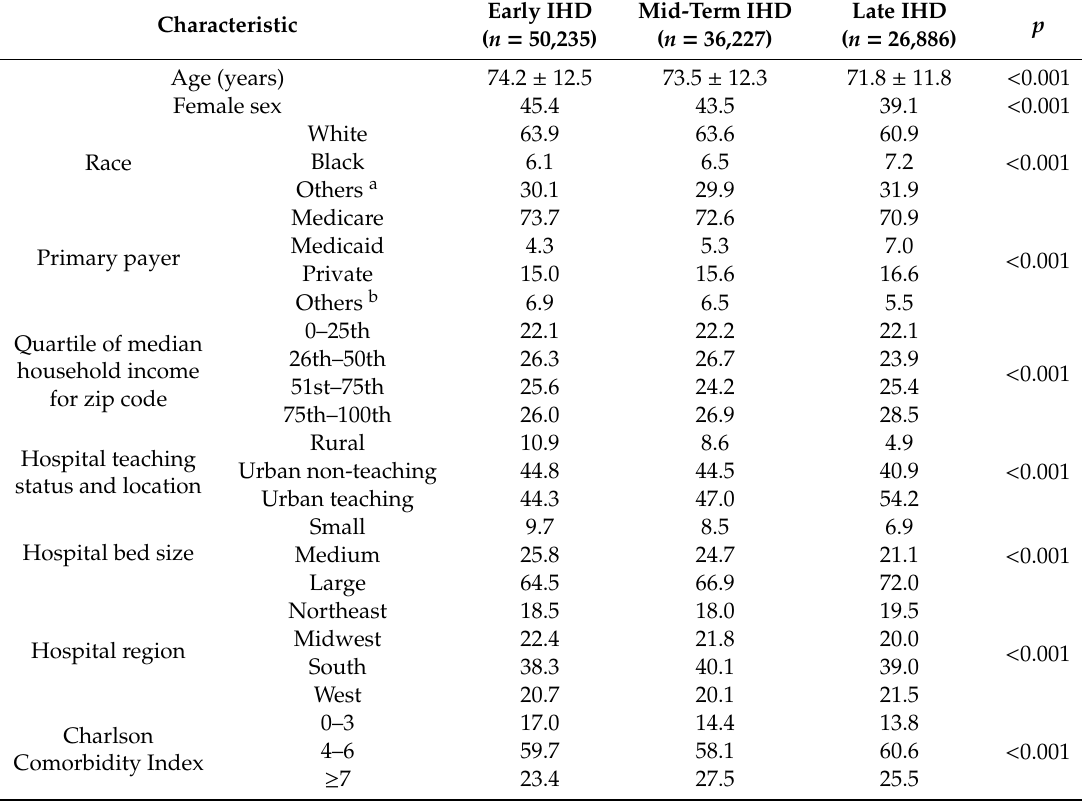
Table 1. Baseline characteristics of AMI-CS stratified by the timing of IHD. Characteristic